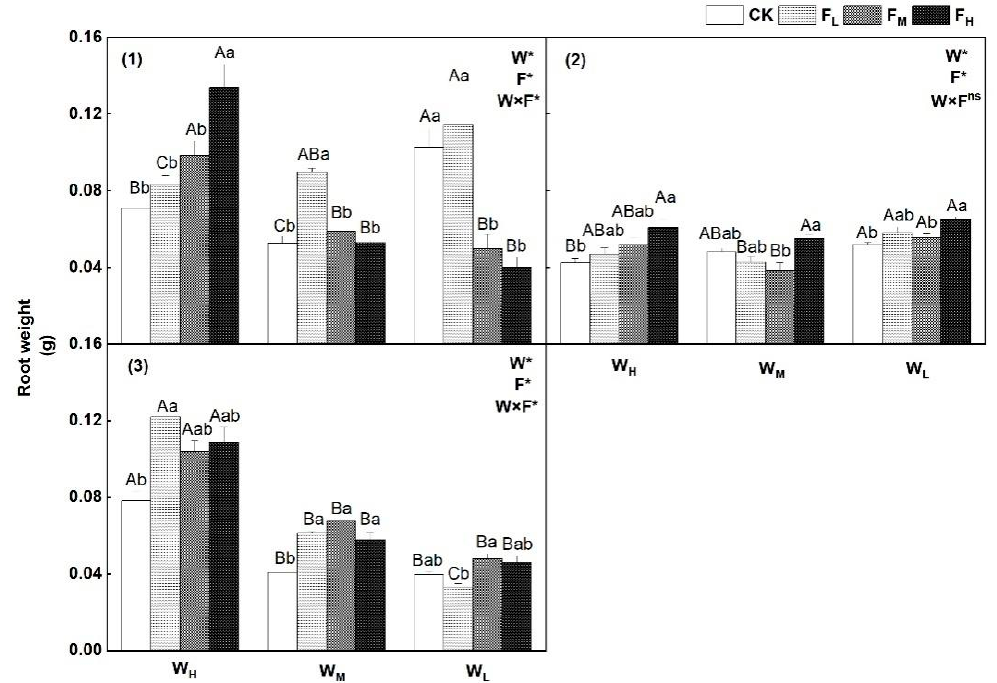
Figure 4. Changes in root weight values of test plant species under different water–fertilizer treat- ments. Numbers ( 1 ) − ( 3 ) in brackets indicate P. crymophila , F. coelestis , and S. purpurea , respectively. W, F, and W×F indicate the results of ANOVAs ( p < 0.05) for the effects of water, fertilizer, and their interactions. Asterisk (*) and ns indicate significant difference and non-significant. The uppercase letters and lowercase letters represent the difference between water and fertilizer treatments.